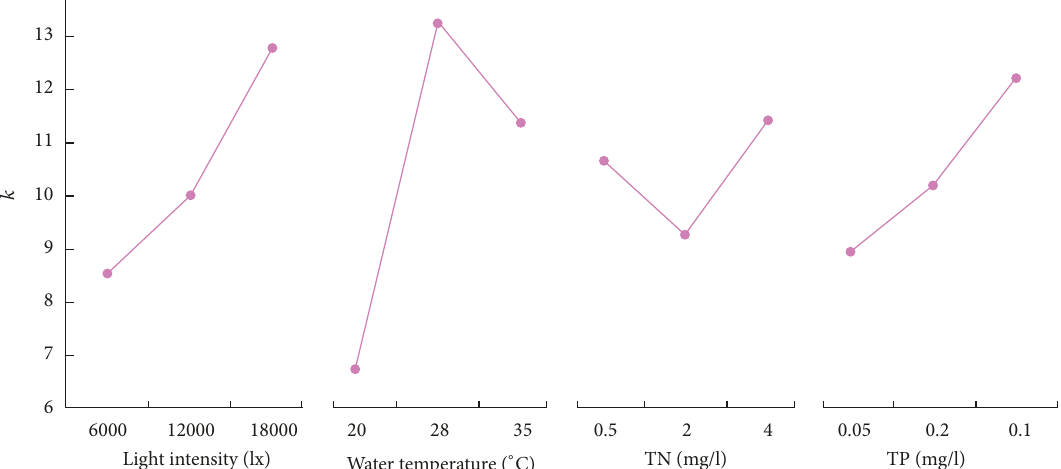
Figure 2: L 9 (3 4 ) orthogonal experiment intuitive analysis diagram of algae maximum daily growth rate.